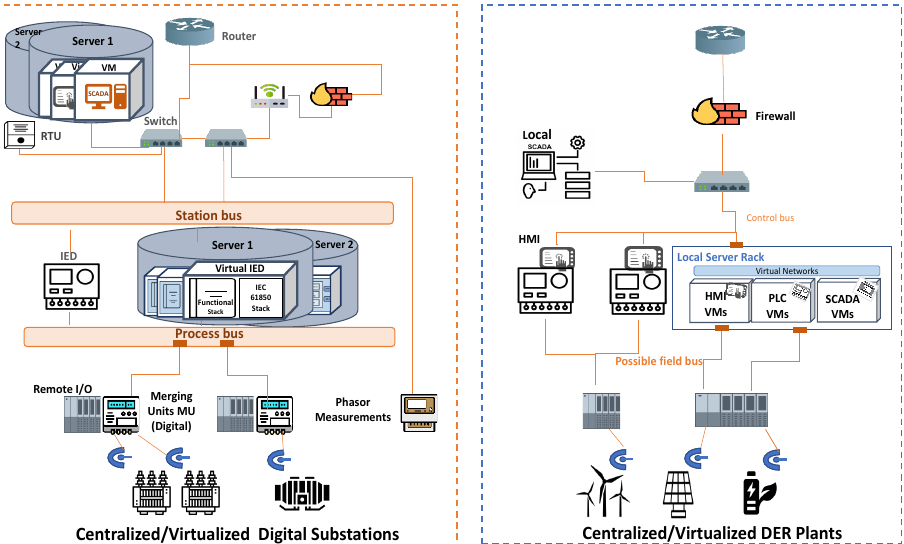
Figure 7. Possible Future Centralized/Virtualized Digital Substation and DER Plant architectures based on Table 3 references where ’Centralized’ refers to the architecture and ’Virtualized’ refers to the